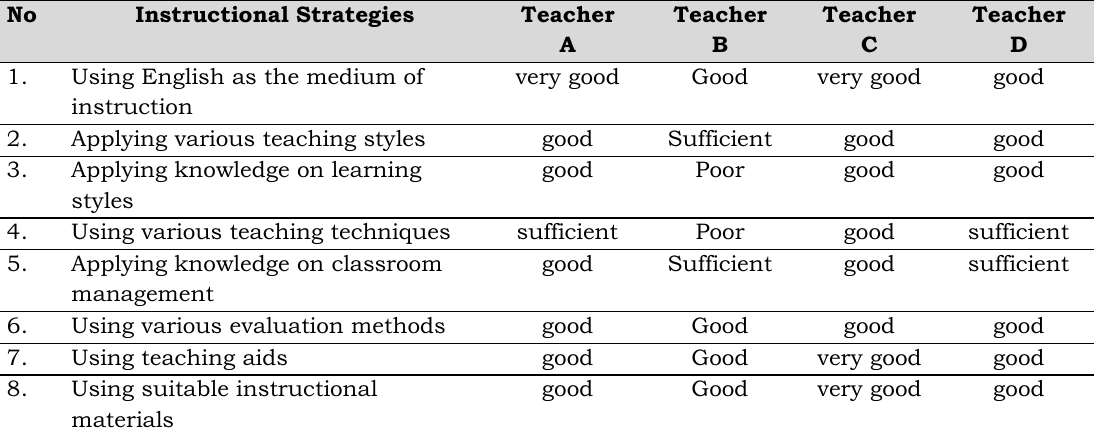
Table 2. Participants